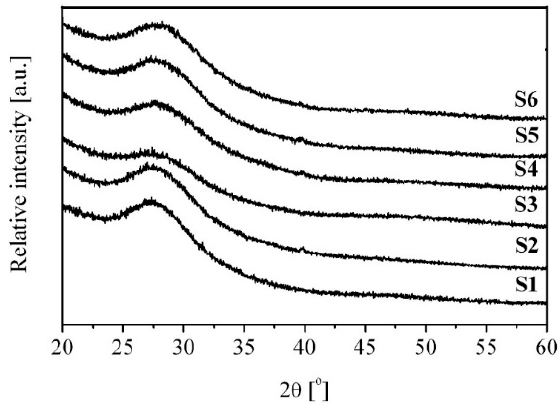
Figure 1. X-ray diffraction patterns of the investigated tellurite